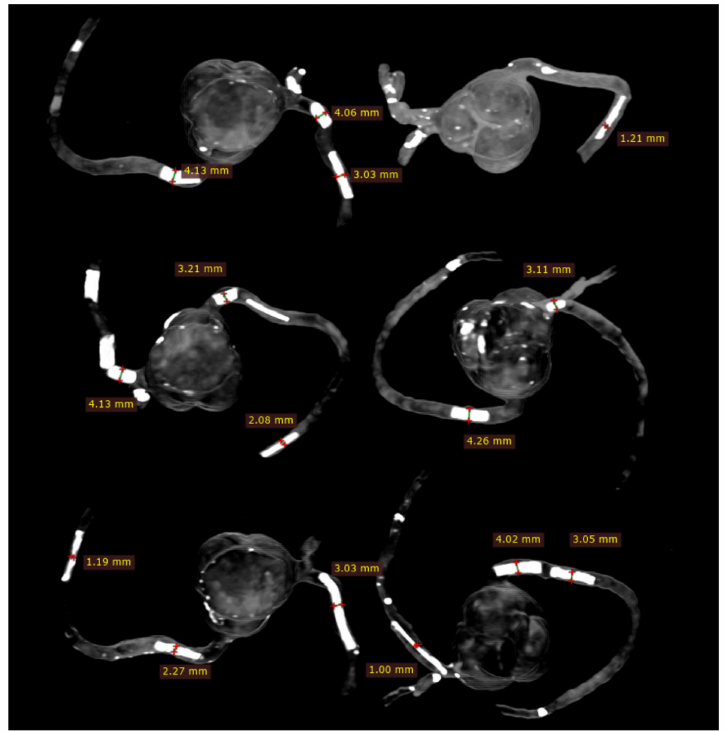
Figure 4. Measurements of plaque dimensions on 2D maximum-intensity projection images using 0.5 mm slice thickness.